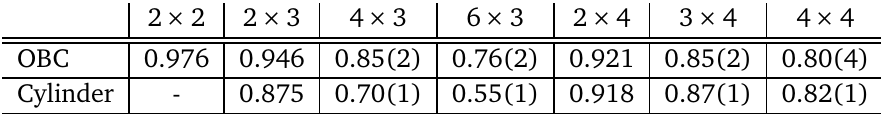
Table 1: Wavefunction overlaps between the ground state of the SU ( 4 ) spin model and the ground state of the Hamiltonian projected onto the subspace of nearest-neighbor singlet coverings for different system sizes ( N indicates open boundary conditions along both x and y , while “Cylinder” indicates periodic boundary conditions along y and open boundary conditions along x . The error indicated in brackets is estimated from the DMRG truncation error for the ground state of the spin model. Values for which no error is indicated were obtained using ED. 2 × 2 2 × 3 4 × 3